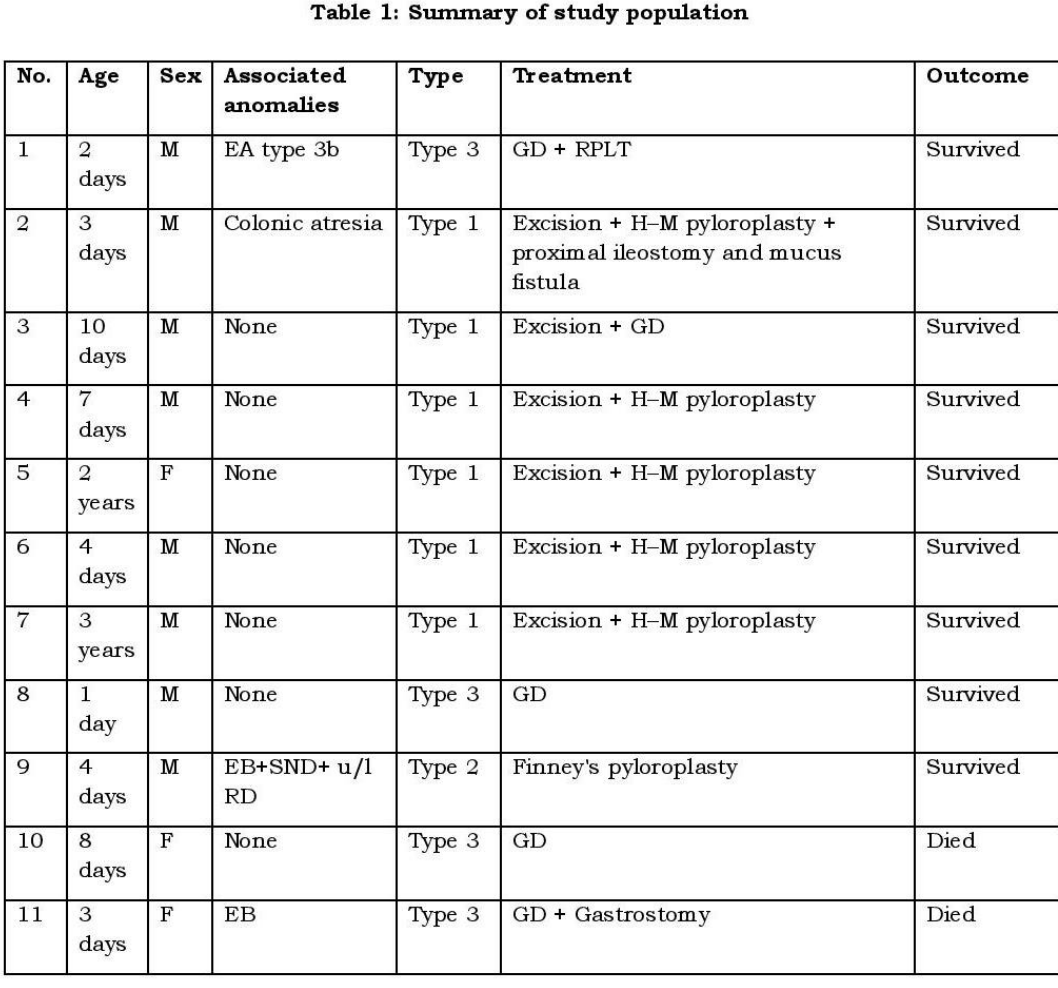
Associated anomalies were seen in four (36.6%). These included epidermolysis bullosa (EB) in two, esophageal atresia with distal trachea-esophageal fistula in one, colonic atresia in one, sensori-neural deafness and [multicystic] dysplastic kidney[ (MCKD)] in one